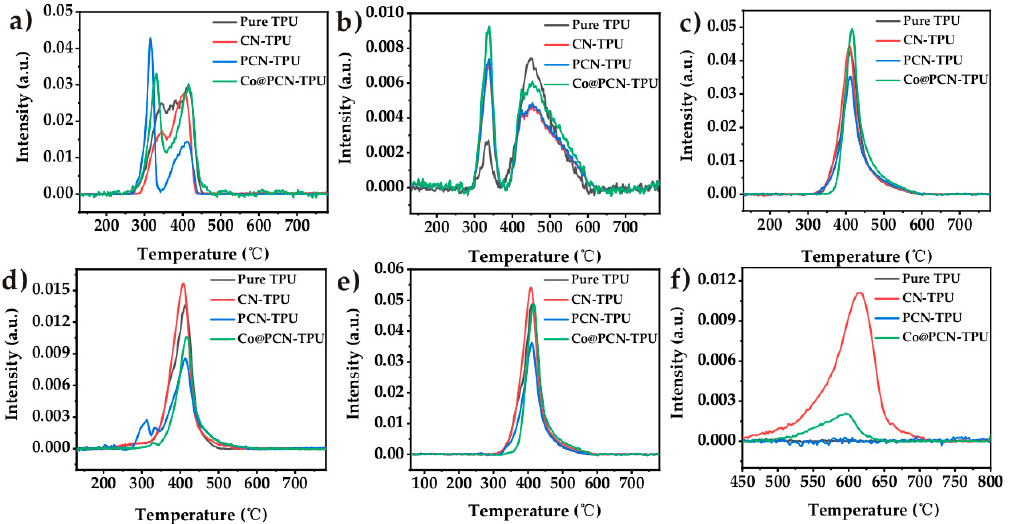
Figure 10. Intensities of characteristic peaks for pyrolysis gaseous products of TPU and its nanocomposites: ( a ) 2358 cm − 1 , ( b ) 1508 cm − 1 , ( c ) 1145 cm − 1 , ( d ) 2977 cm − 1 , ( e ) 1751 cm − 1 , and ( f ) 714 cm − 1 .